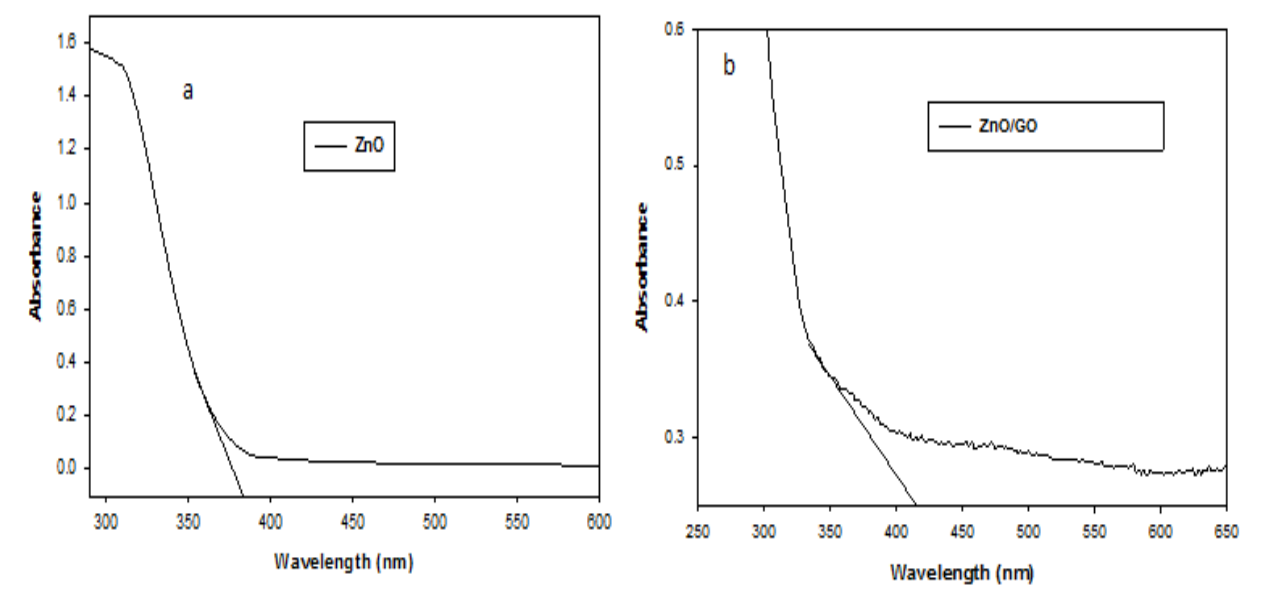
Figure 4. ZnO absorption spectrum ( a ) and ZnO/GO absorption spectrum ( b